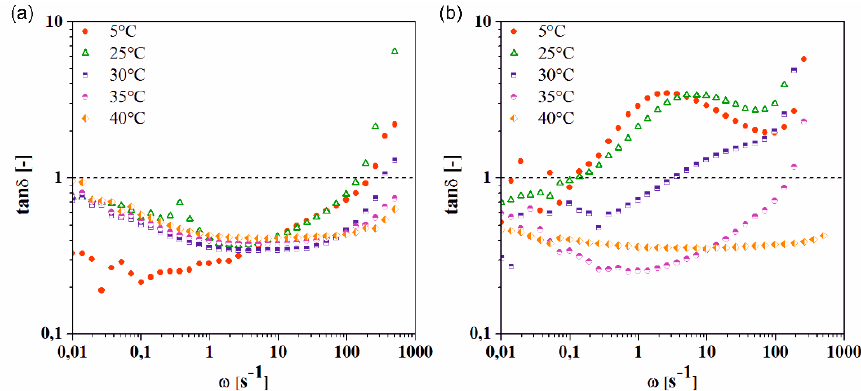
Figure 2. Comparison of mechanical spectra of colloidal chitosan solutions with calcium β - Figure2. Comparisonofmechanicalspectraofcolloidalchitosansolutionswithcalcium β -glycerophosphate glycerophosphate ( a ) and sodium β -glycerophosphate ( b ). ( a ) and sodium β -glycerophosphate ( b